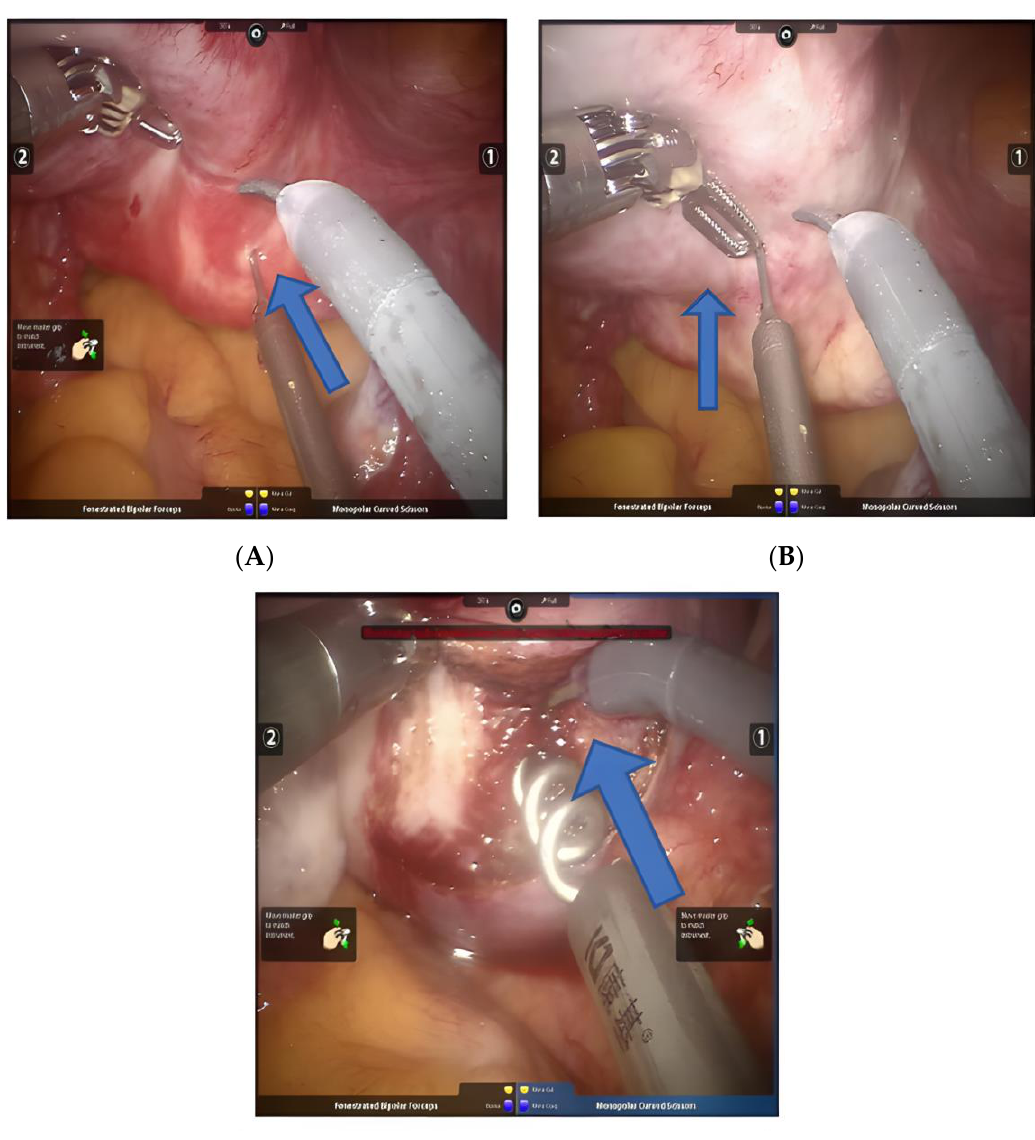
Figure 3. ( A ) Terlipressin was injected into the uterine body. ( B ) “Water cushion method” was used to isolate fibroids. ( C ) The fibroids were pulled with fibroid screws ("Kangji" brand fibroids screws). Arrows point to injection and pulling directions.